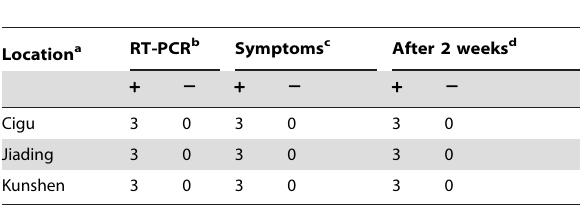
Table 1. Nervous necrosis virus (NNV) detection results from infected grouper fish from 3 different fish